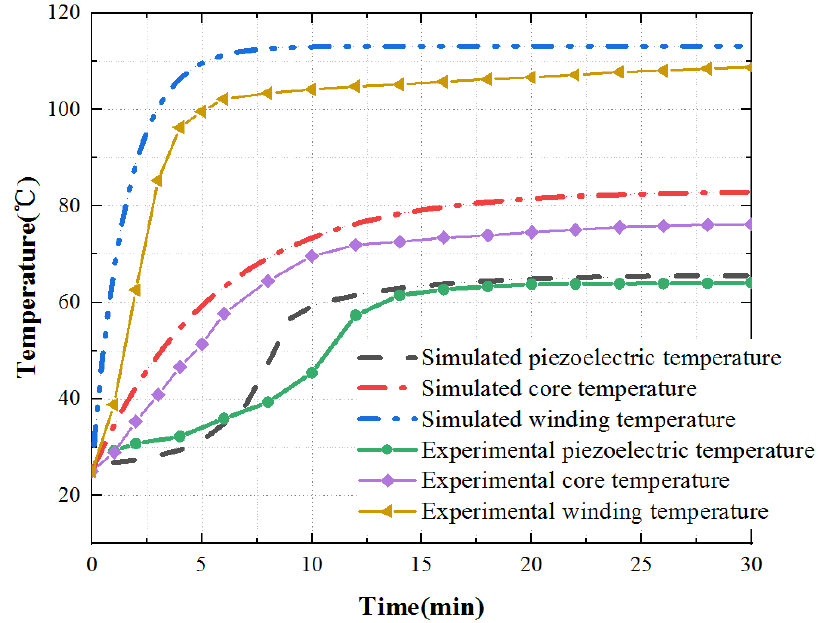
Figure 23. Comparison of simulation and experimental data. According to the experimental and theoretical analysis, outcomes show that the temperature rise trend obtained by the experimental and theoretical analysis is consistent. In the steady-state, the experimentally measured value is slightly lower than the theoretical value. This difference is mainly due to the influence of the external environment on the actual situation. In the temperature rise stage, the temperature rise of key parts first increases and then tends to be stable. However, there is a slight difference in the temperature rise of the piezoelectric stator. This difference is because the PCS is stuck to the stator substrate after silver plating and polarization, and the bonding layer will